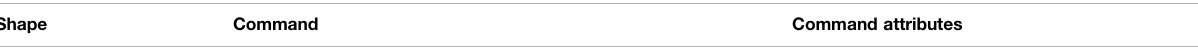
TABLE 1 | Classi fi cation of different types of shapes and their corresponding gestures.